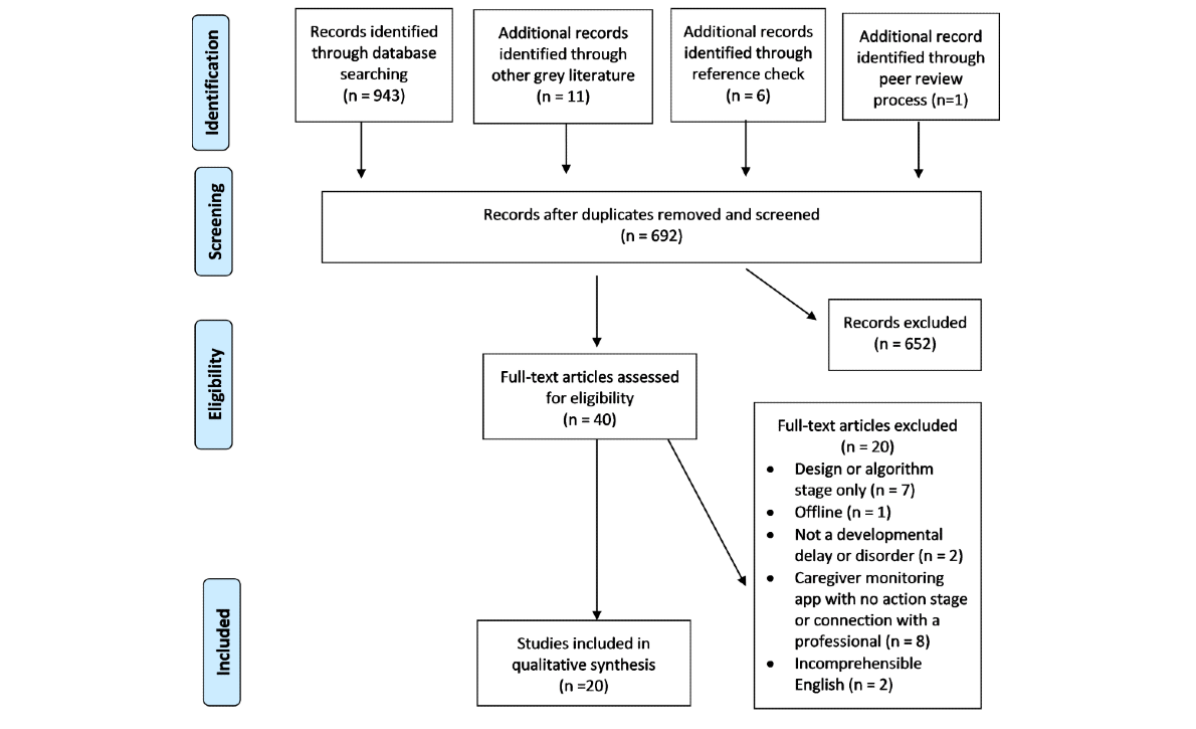
Figure 1. Preferred Reporting Items for Systematic Reviews and Meta-Analyses flow